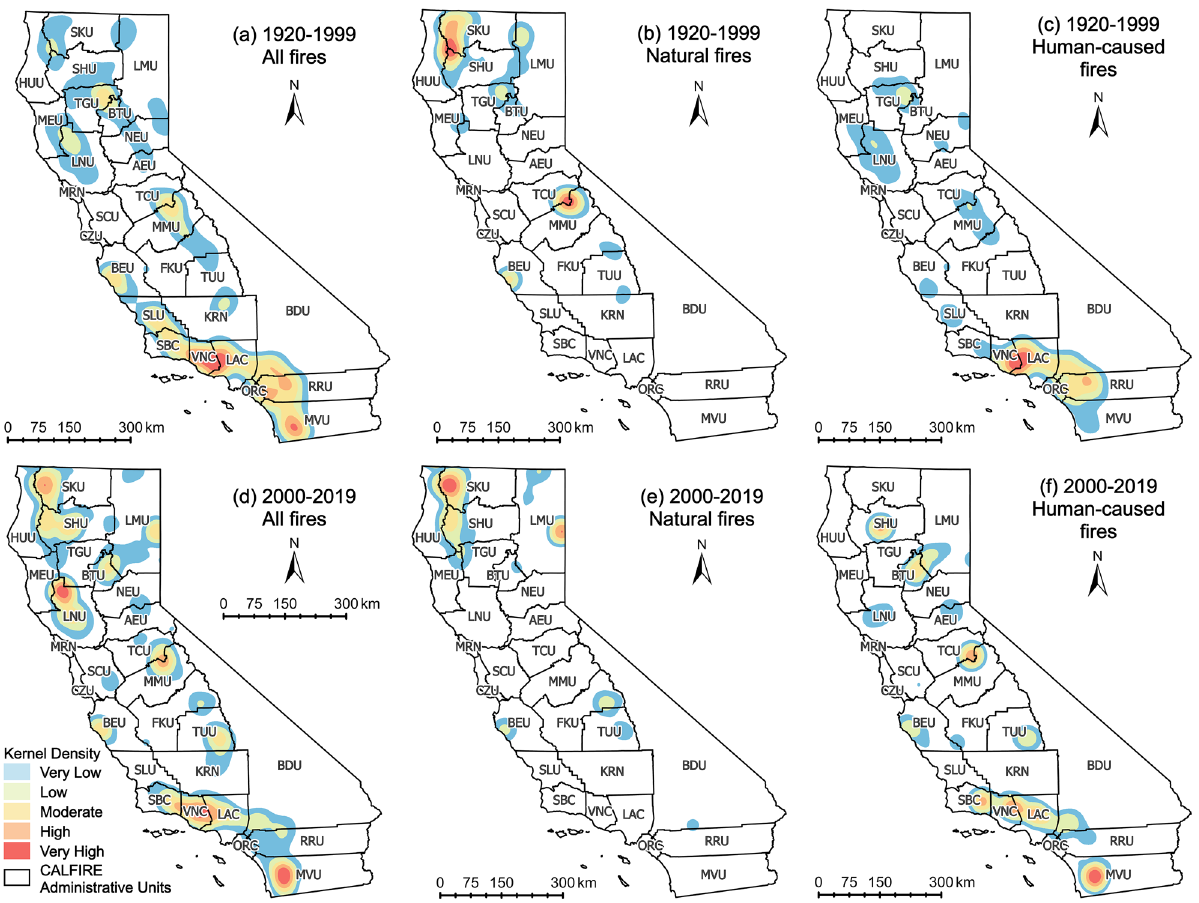
Figure 7. Kernel density distribution of burned area weighted wildfire occurrence in CA during 1920–1999 ( a – c ), and 2000–2019 ( d – f ). ( a – f ) are wildfire density distribution maps for all wildfires, natural wildfires and human-caused wildfires in CA,